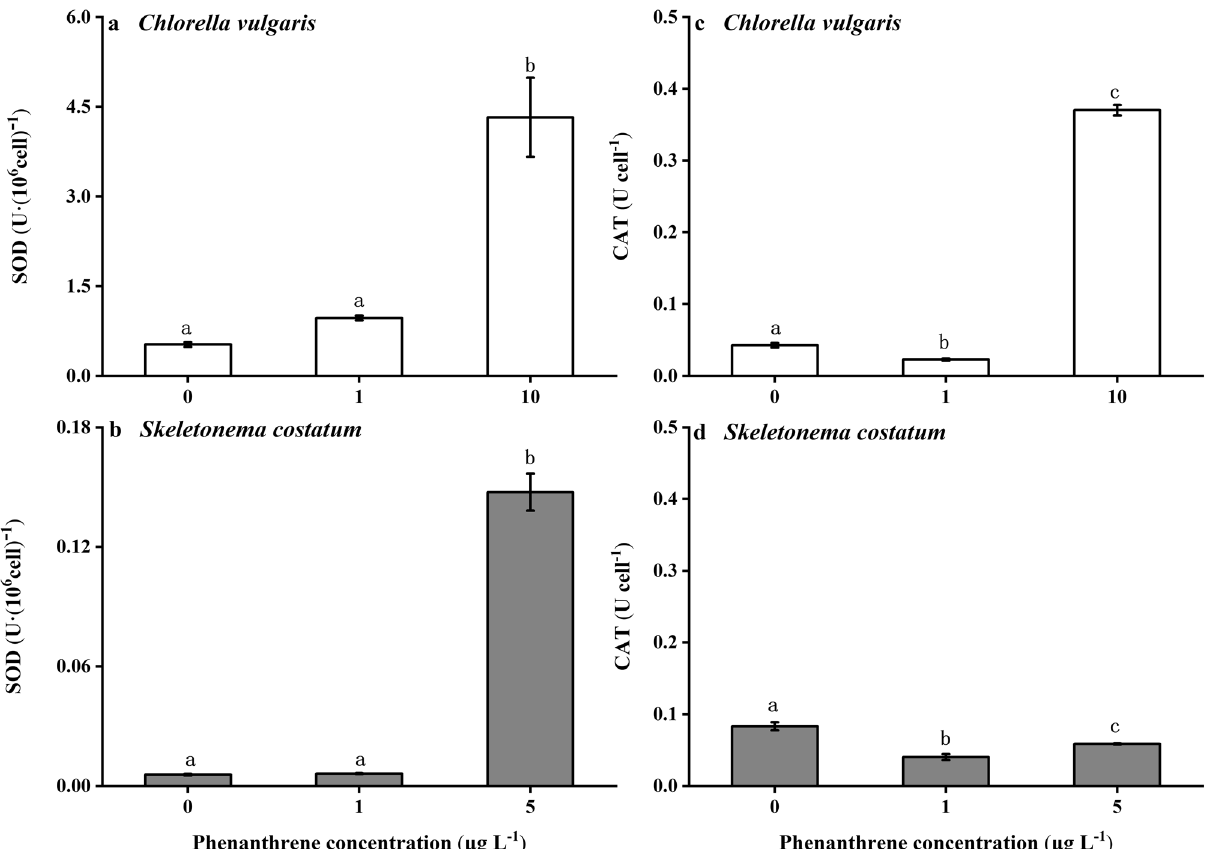
Figure 6. The superoxide dismutase (SOD) (a,b) and catalase (CAT) (c,d) activity of Chlorella vulgaris (a,c) and Skeletonema costatum (b,d) cells at different phenanthrene concentrations. The data are means ± SD of triplicate cultures (n = 3). The different lowercase letters indicate significant ( p < 0.05) differences between phenanthrene concentrations in one species (one-way ANOVA and post-hoc Tukey